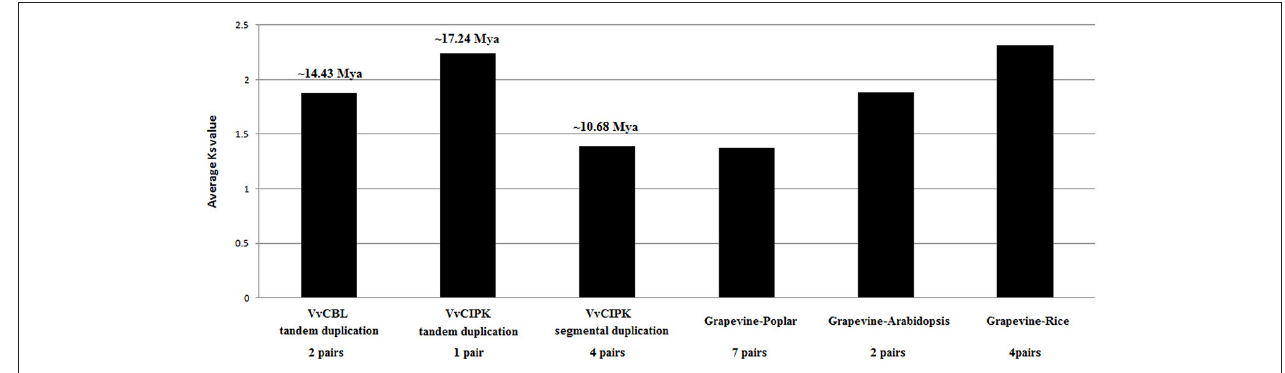
FIGURE 4 | Duplication and divergence based on synonymous substitution rate (Ks) estimated using paralogous and orthologous VvCBL and VvCIPK gene pairs.